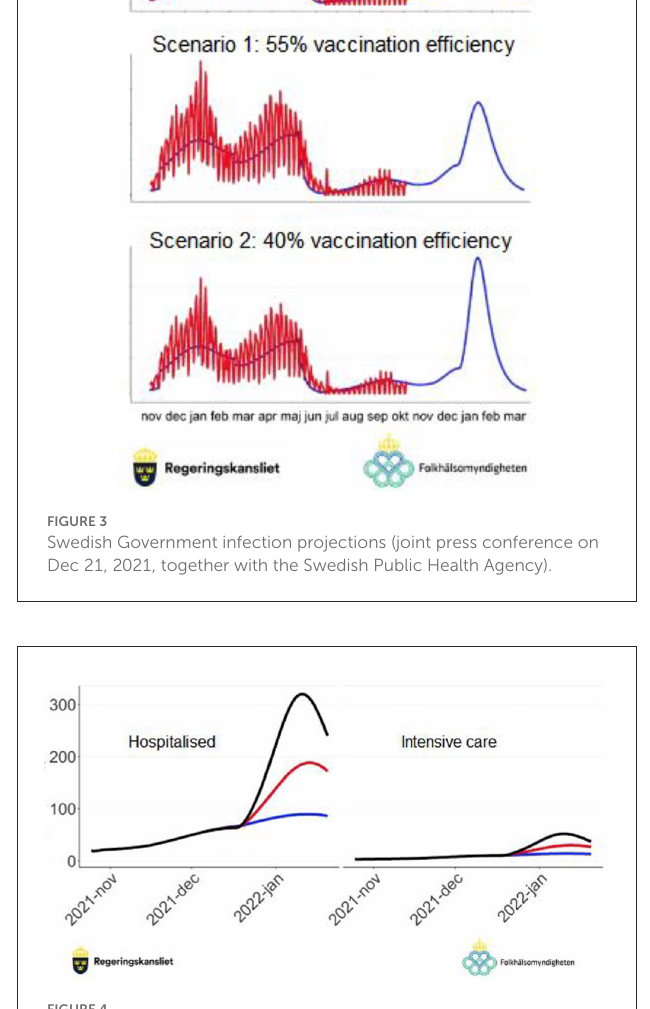
FIGURE4 Prognosis on the number of new hospitalised cases per day (left) and the number of new cases in intensive care per day (right) in